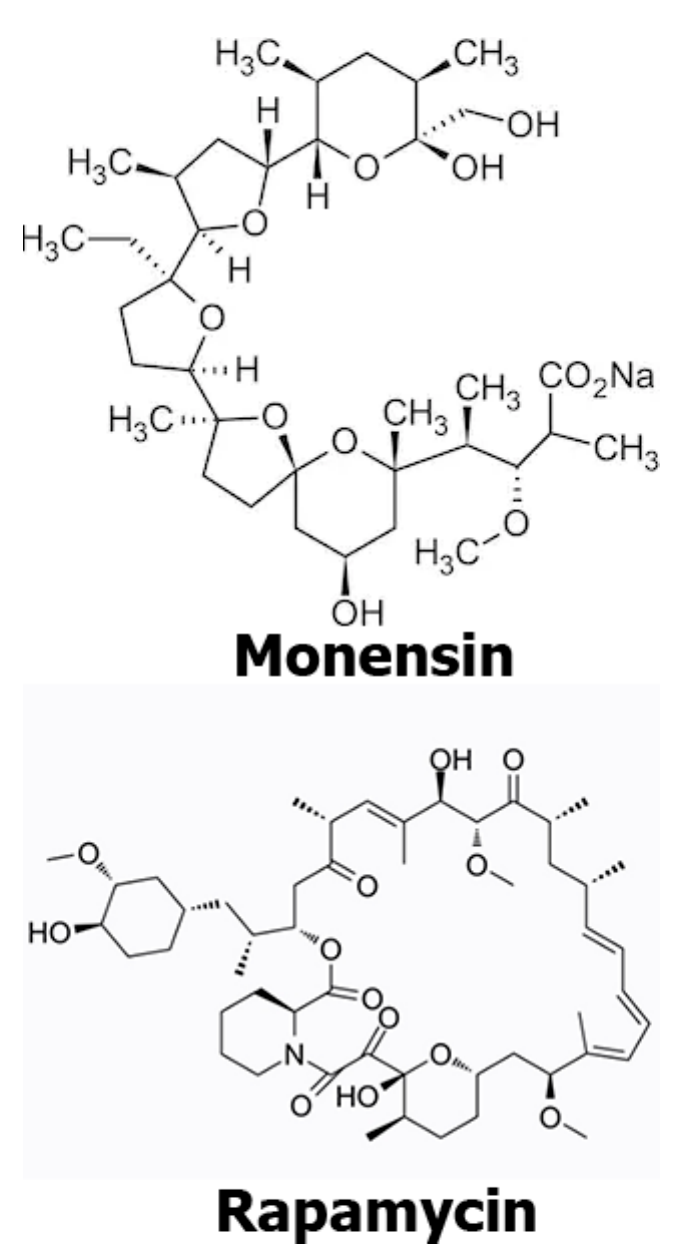
Figure 1. Chemical structures of mon and rap. Table 1. The toxic effects of the combination of mon (monensin) and rap (rapamycin) on SH-SY5Y cells were evaluated using the Chou Talalay combination index (CI) at 48 and 72 h.